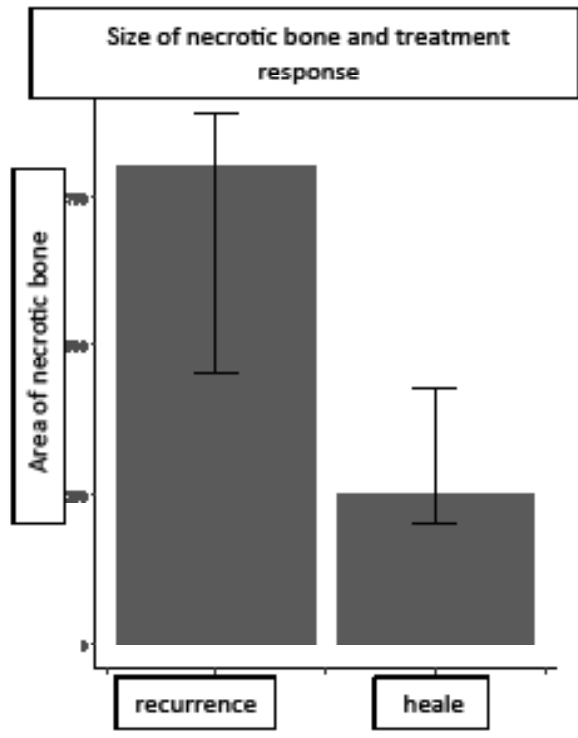
Fig. 4. Association between defect size and status of healing. Shown as median and 95% confidence